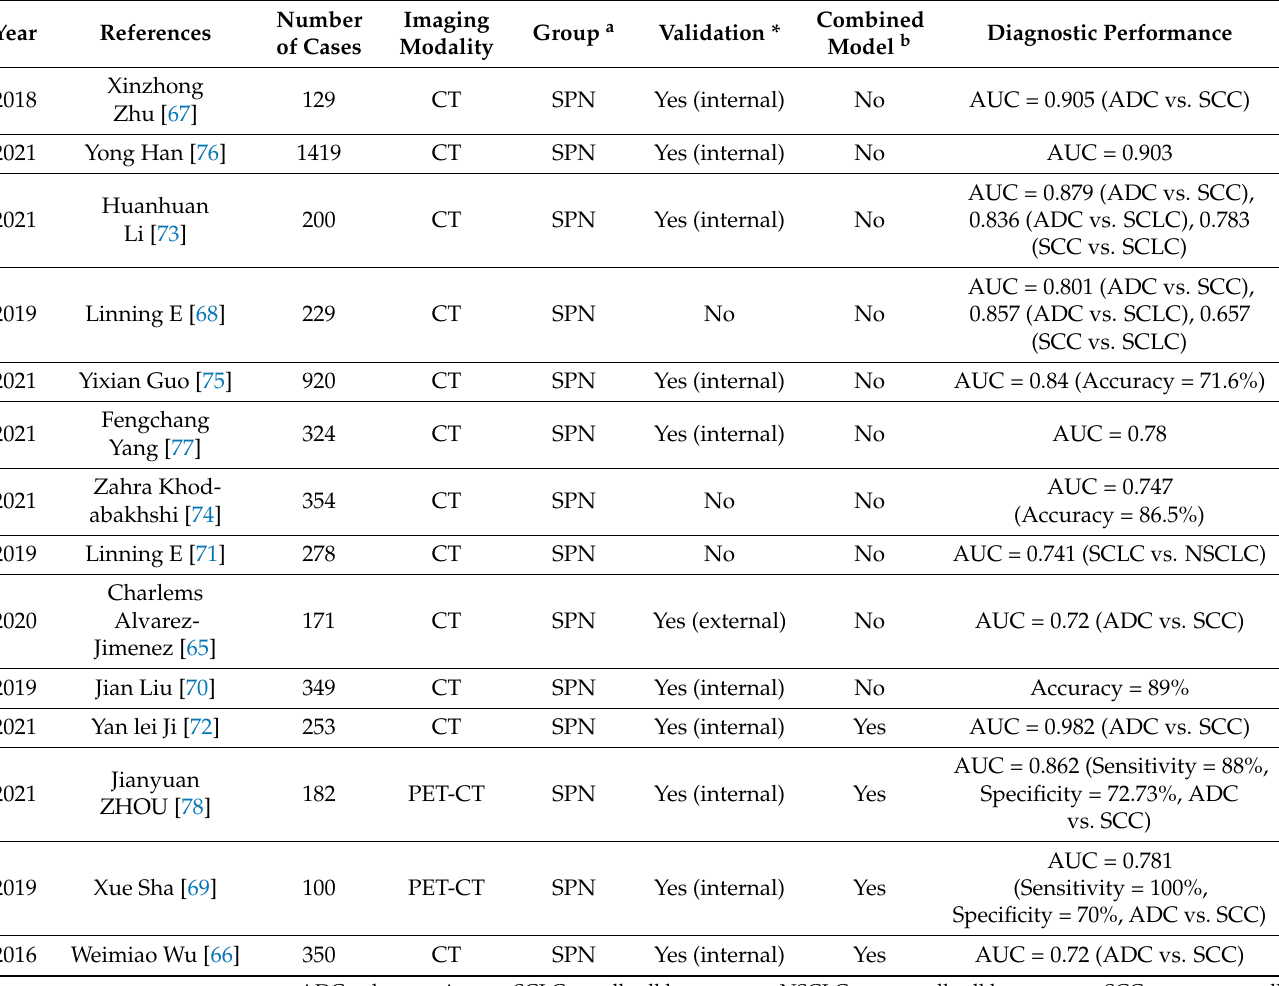
Table 3. Description of studies using different radiomics featured to determine the histologic subtype classification of lung